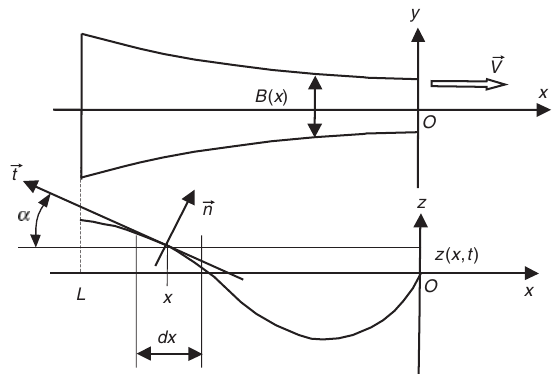
Figure 6 Motion and propulsive force analysis of the GMF fin. The propulsive force along x axis is (Zhang and Liu